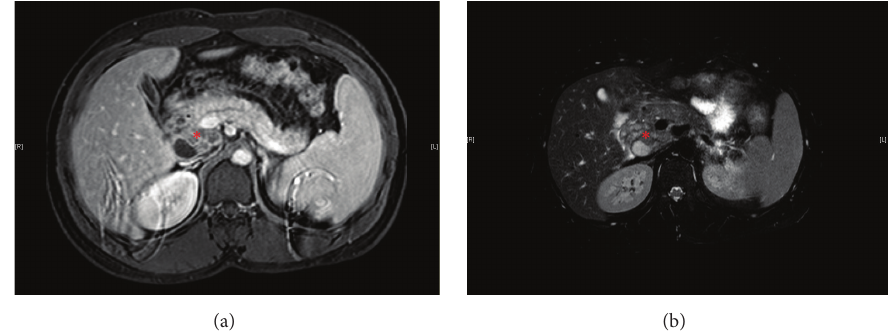
Figure 1: Axial abdominal MRI. (a) T1 MRI with contrast in arterial phase and (b) T2 MRI. Demonstrating a multiloculated complex cystic mass at the posterior aspect of the pancreatic head with heterogeneous content and enhancing septations (asterisk). It measures 4.7 × 4 cm with mild mass effect on the portal vein and no definite communication with common bile duct or pancreatic duct.